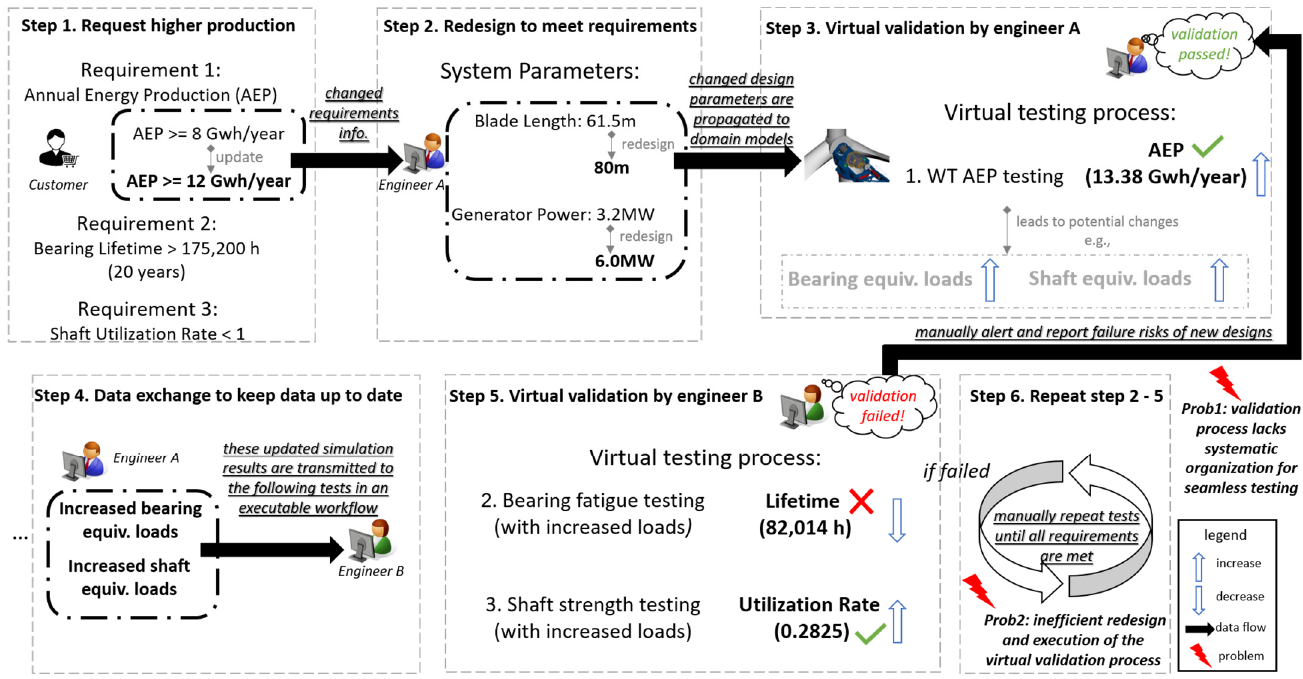
Figure 2. The classical virtual validation process of the development of a WT system and its com ‐ ponents by the two design engineers. Adapted from [19].